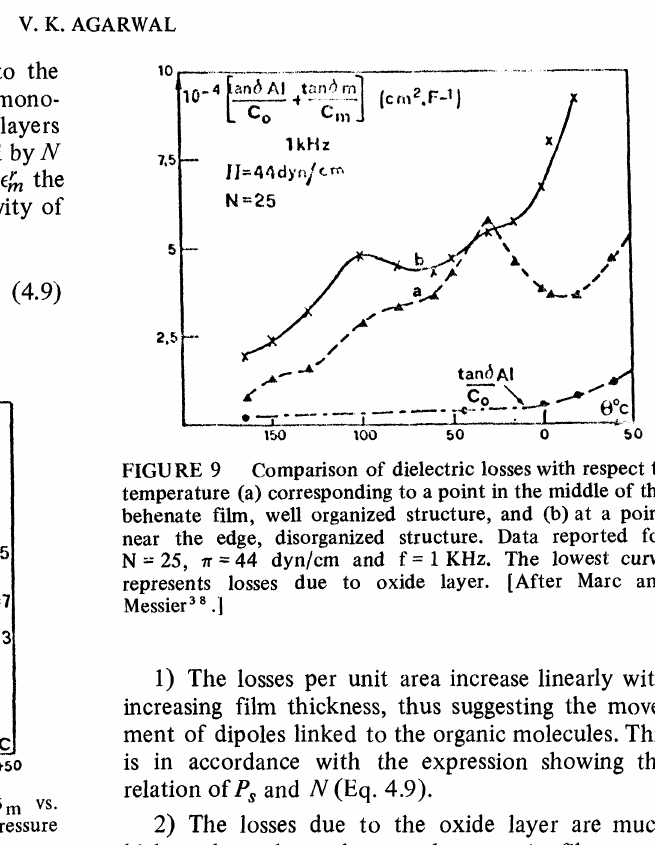
FIGURE 8 Loss angle of behenate layers tan 6 m vs. temperature 0 measured at f KHz and at a surface pressure rr of 44 dyn/cm. [After Marc and Messier .]